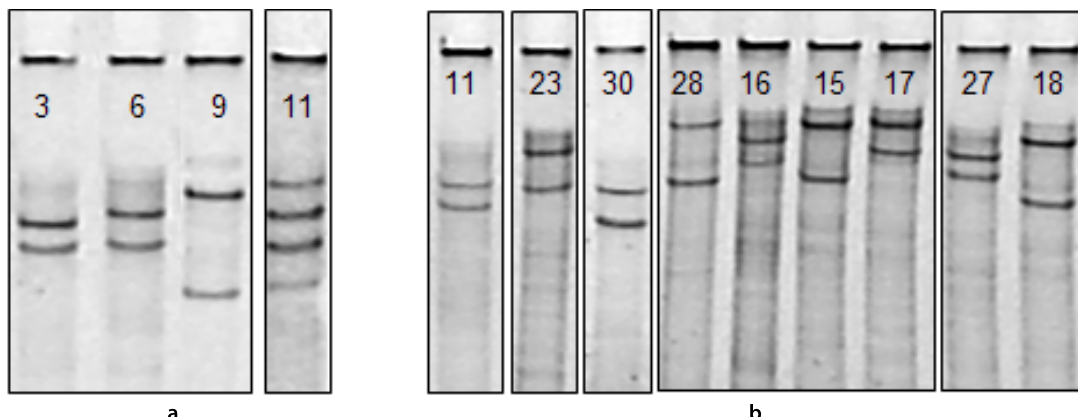
a Figure 1. SSCP patterns obtained from the RT-PCR amplicons of (a) infected plants (GR3, GR6, GR9, CTV11) and (b) their haplotypes subsequently sequenced. Citrus tristeza virus (CTV) isolates: GR3, Mexican lime grafted with the isolate from Argolida (haplotype 11); GR6, Sweet orange from Chania (haplotypes 23, 30); GR9, Lemon from Poros (haplotypes 28, 16, 15, 17); and CTV11, Calamondin from Italy (haplotypes 27, 18).